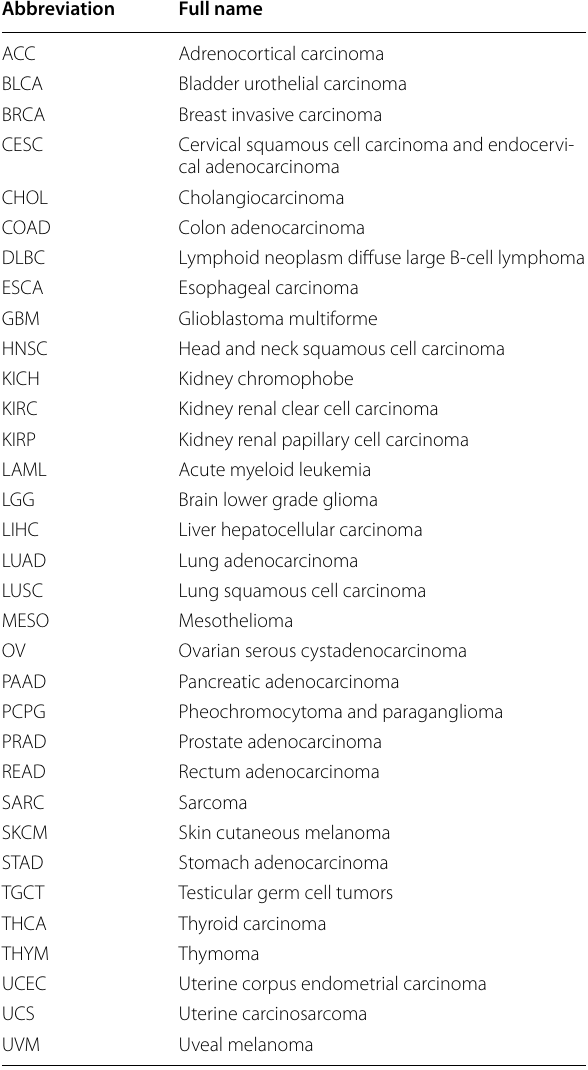
Table 1 Abbreviations and full names of all TCGA